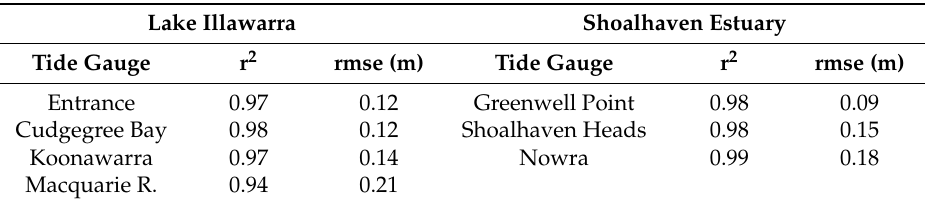
Table 1. Statistical measures derived from comparison of modelled and observed water levels for the present-day storm surge simulation at Lake Illawarra and the Shoalhaven